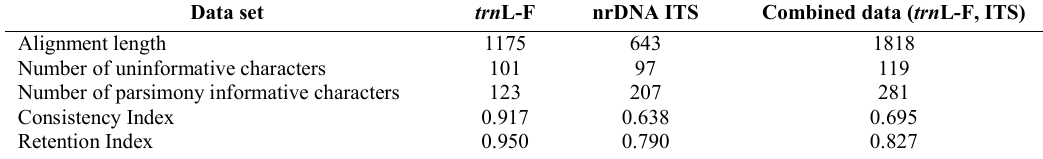
Table 4. Statistics of trnL-F, ITS, and combined nuclear and chloroplast region analyses of Consolida